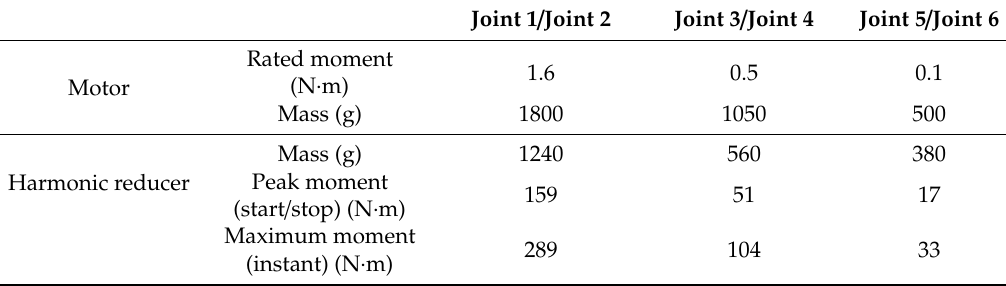
Table 2. Primary parameters for the motor and